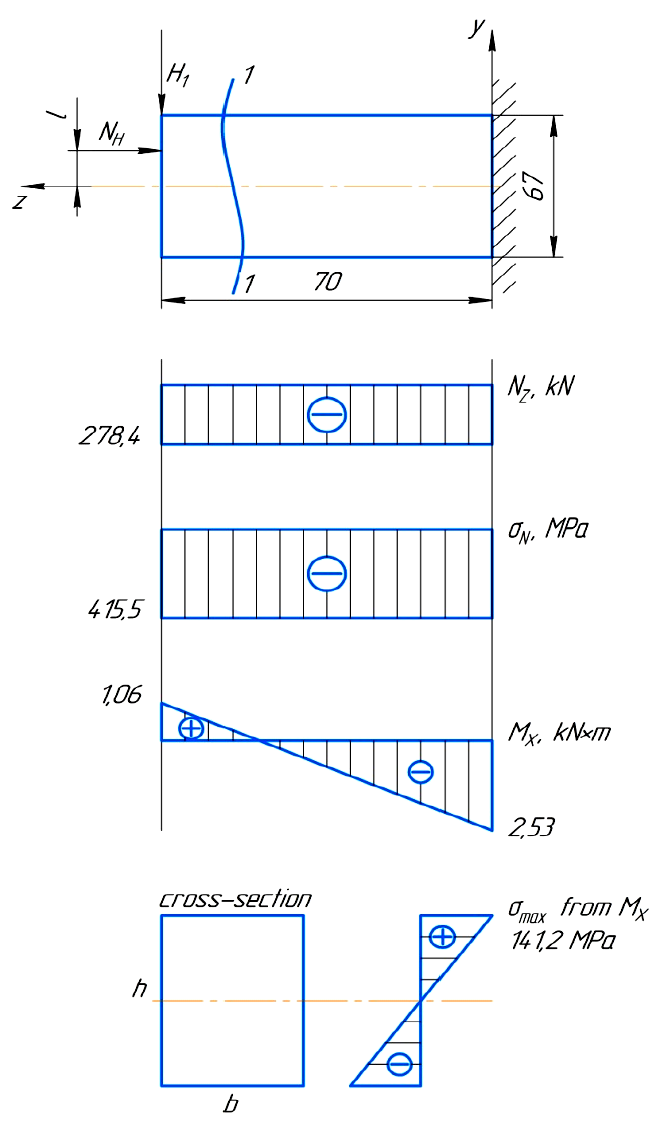
Figure A1. Curve of acting forces and stresses.